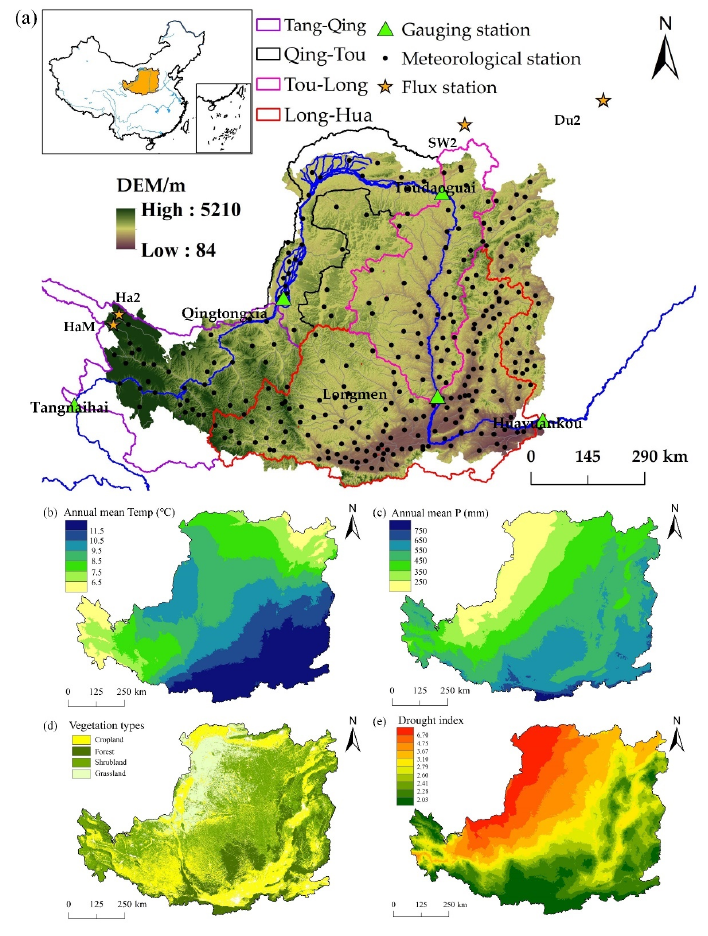
Figure 1. ( a ) Location of the Chinese Loess Plateau, annual mean of ( b ) temperature and ( c ) precipitation, ( d ) vegetation types, and ( e ) drought index.